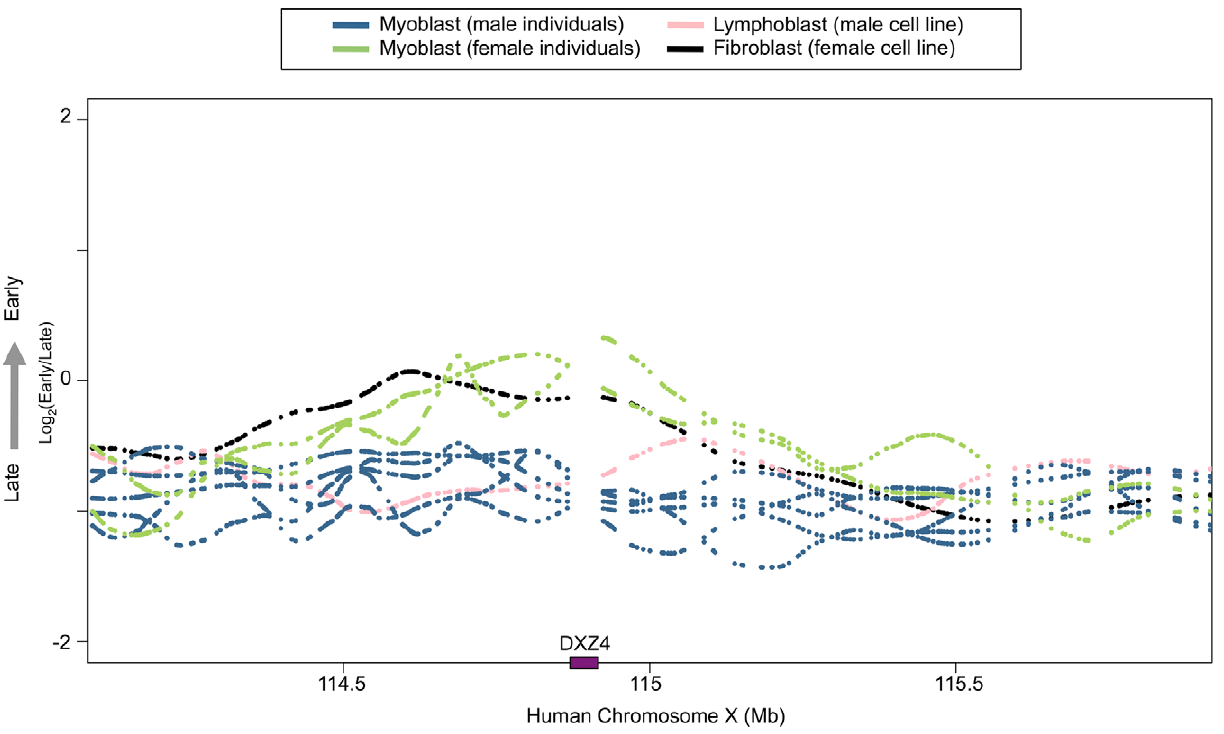
Figure 6. The region containing DXZ4 replicates early on the inactive X chromosome. Primary human myoblast replication timing profiles are shown for 2 female (green) and 5 male (blue) individuals across the DXZ4 locus on chromosome X. Profiles for male lymphoblastoid (pink) and female fetal lung fibroblast (black) cell lines are also shown. Gaps in each profile represent regions between microarray probes. The purple box on the x-axis marks the position of DXZ4.